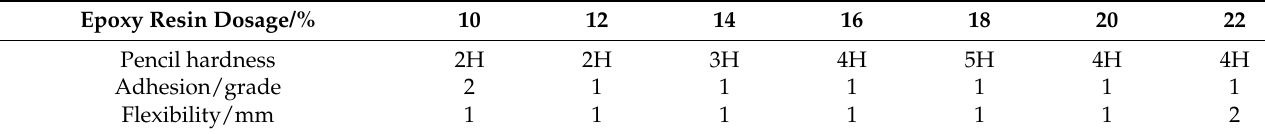
Table 5. Effect of epoxy resin dosage on coating film properties.